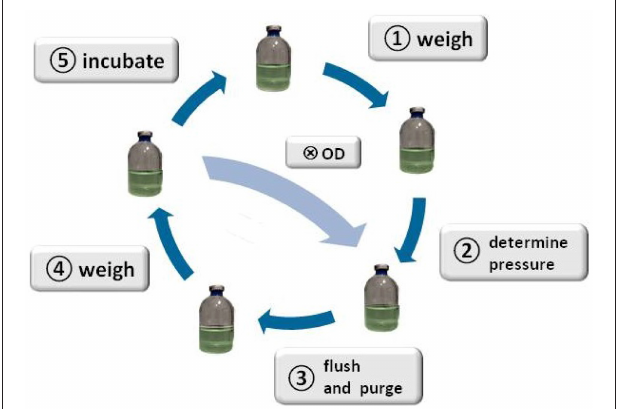
FIGURE 1 | Schematic illustration of the method. The figure illustrates the SOP: start with weighing the serum bottles h 1 , determine the head space pressure of the serum bottles h 2 , flush and purge to remove CH 4 from the headspace of the serum bottles h 3 , weigh the serum bottles h 4 , incubate the serum bottles h 5 , start again with step h 1 ; taking a sample h X for OD measurement or cell counting is optional after step h 4 , whereas step h 3 and h 4 would have to be repeated after sampling for OD